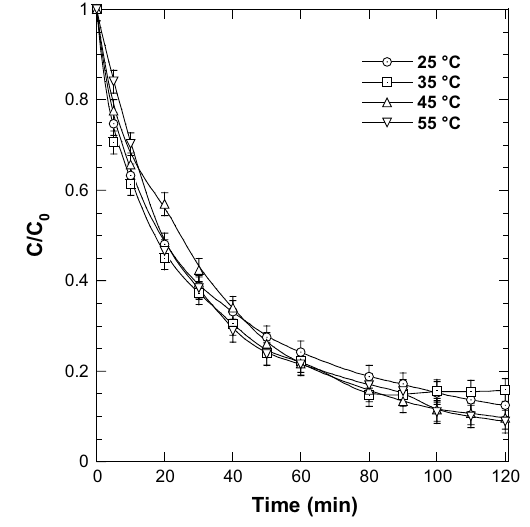
Fig. 11 Effect of formic acid (FA) addition on the degradation kinetics of TB (conditions—volume: 100 mL, initial TB concentra- tion: 20 mg L −1 , initial FA concentration: 0.1–1 g L −1 , temperature: 25 ± 2 °C, pH ~ 6, frequency: 1700 kHz, power: 15